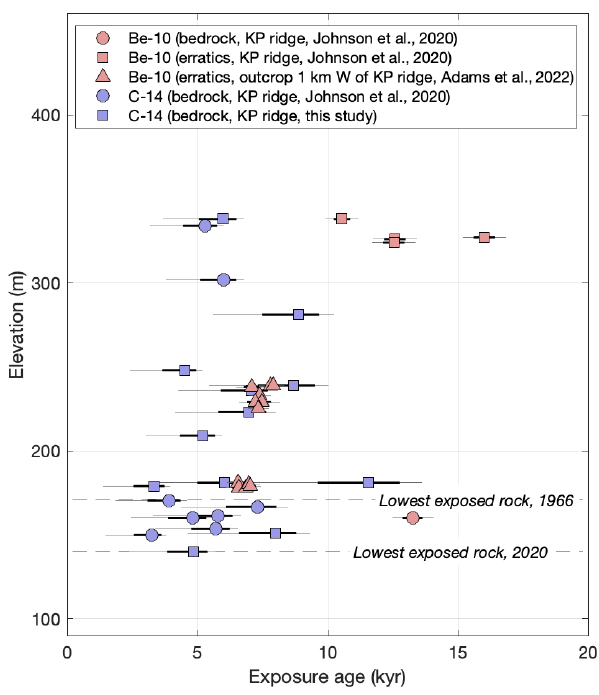
Figure 4. Apparent 10 Be and 14 C exposure ages for bedrock and erratic samples from the ice-free section of Kay Peak Ridge, in- cluding data already published in Johnson et al. (2020) and addi- tional measurements in this study (see Methods 2 and Tables S1 and S5 in the Supplement). All data are also available through the ICE-D:ANTARCTICA database at http://www.ice-d.org (last ac- cess: 22 April 2023). Apparent 10 Be exposure ages from an ad- jacent outcrop 1km west of Kay Peak Ridge, described in Adams et al. (2022), are also shown. Error bars indicate the 68% (thick line) and 95% (thin line) confidence intervals. “Apparent exposure ages” are exposure ages calculated from measured nuclide concen- trations with the assumption that samples have experienced a single period of exposure at their present location without burial or surface